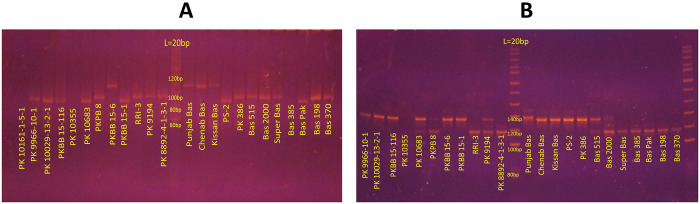
DNA banding patterns in some rice accessions.The 8% polyacrylamide gel electrophoresis pictures showing DNA banding patterns in some rice accessions generated with SSR marker (A) RM 335 and (B) RM 402. A 20 base pair ladder is presented in the middle of each figure.